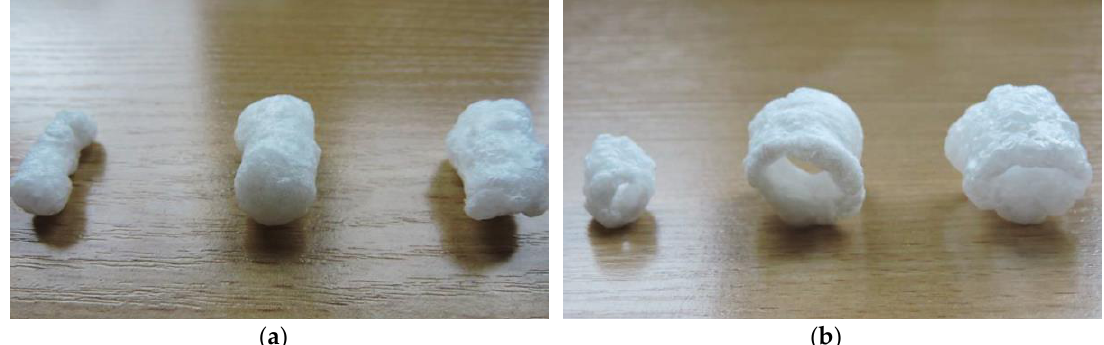
Figure 1. Obtained starch-based foams: ( a ) circular die and ( b ) ring die.